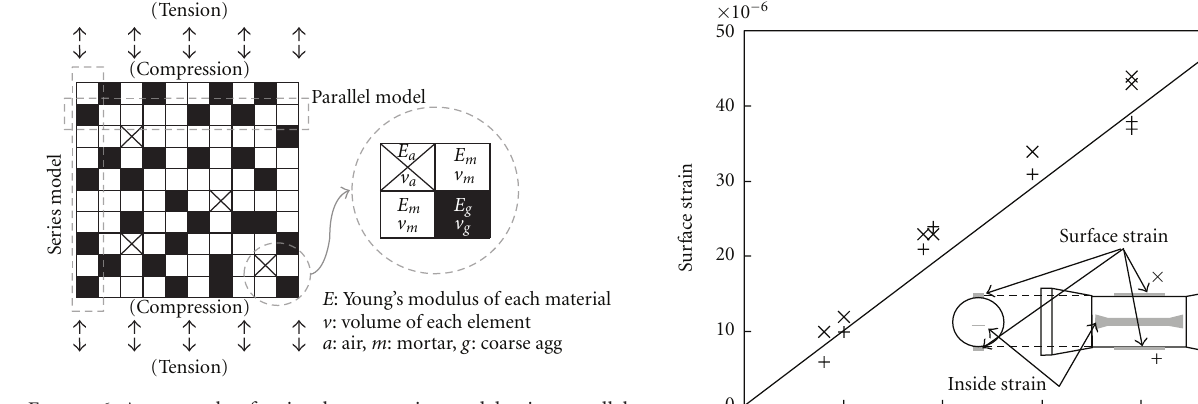
Figure 6: An example of a simple composite model using parallel and series models.